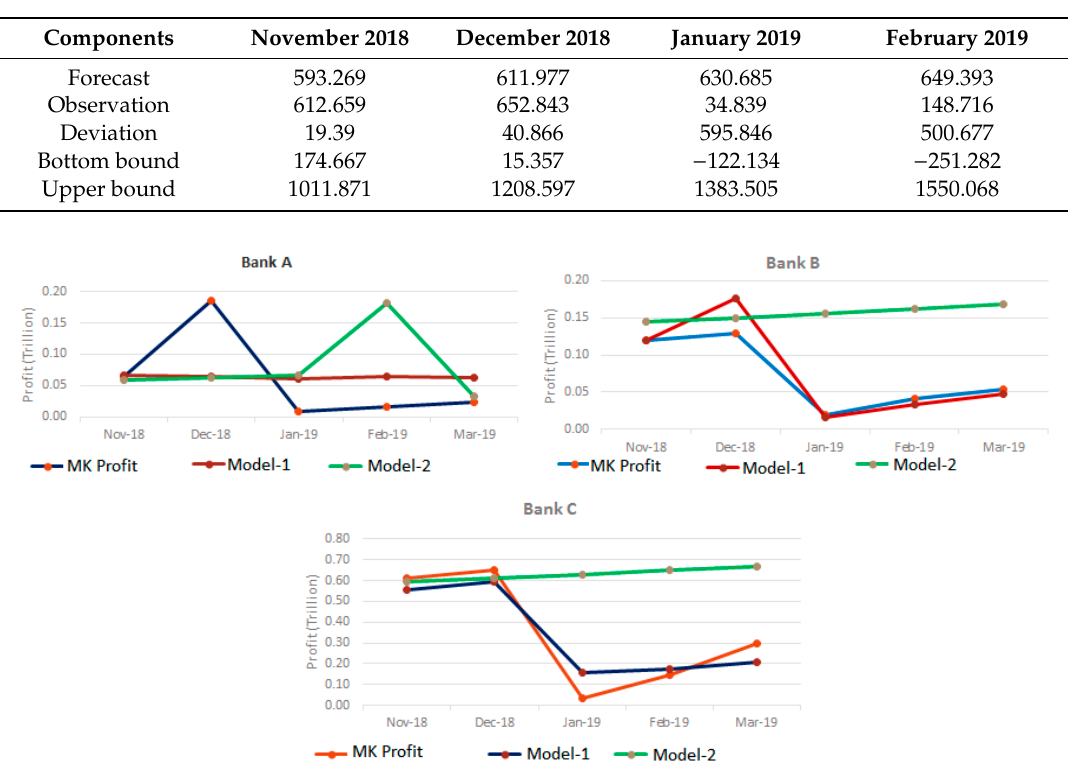
Figure A7. Comparison of profits of MK calculation (observed data), Models-1 and Models-2 for Banks A, B and C.